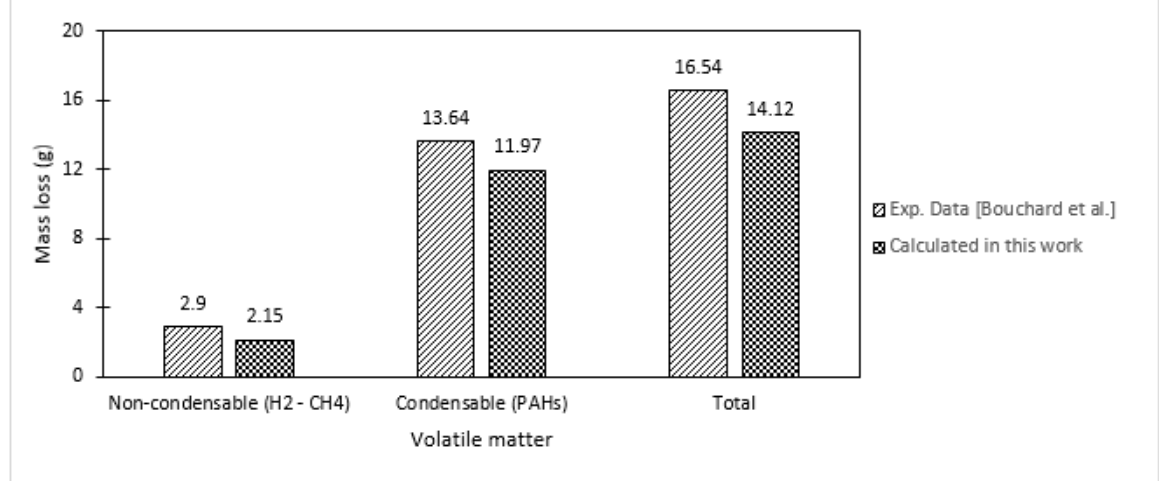
Figure 16. Calculated molecular weight distribution of the residue of a 50 g mass coal tar pitch during coke formation step (where the temperature is about 550 °C) of carbonization process with heating rate of 50 °C/h. It is important to point out that the proposed model can be applied to estimate the mass loss of CTP during the primary carbonization by using any available set of experi ‐ mental data, not necessarily Bouchard’s data, to calibrate the model and following the overall procedure defined above (with some changes in certain aspects of the model). 3.2.2. Estimation of Energy Requirement of Different Steps of CTP Primary Carbonization The energy required in the first step of CTP heat treatment (25 to 350 °C) can be cal ‐ culated by following the procedure explained in Sections 2.3 and 2.4. This energy is re ‐ quired both to increase the temperature of pitch to any given temperature and to match the mass changes at that temperature estimated in Section 3.2.2. Starting with a 50 g sam ‐ ple of CTP (MWD shown in Table 6) at room temperature, calculated total required energy at any given temperature in the range of 25–350 ° C is presented in Figure 17. The results obtained in Section 3.2.1 for mass changes of CTP with temperature (every 5 ° C) have been used in this calculation.